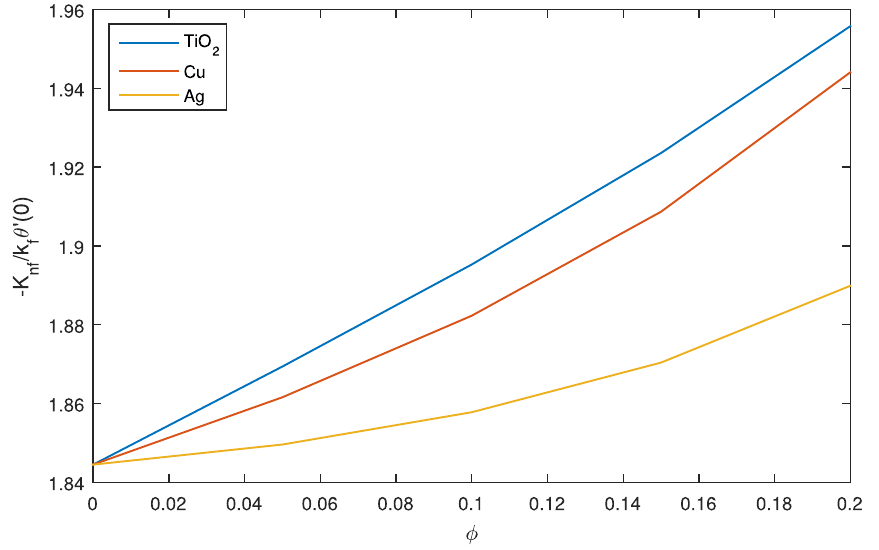
0.1 , w 0.1 , β 0.1 , ζ 0.2 = = = ◦ =